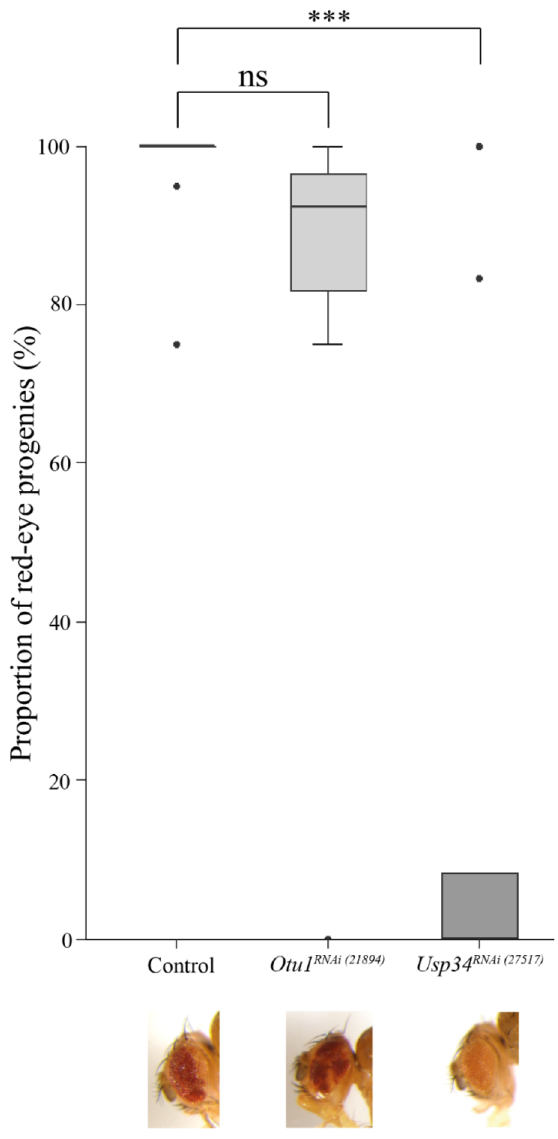
Figure 3. Phenotypic changes were obtained using I-SceI-induced site-specific DSB system in Otu1 RNAi (21894) and Usp34 RNAi (27517) DUB mutants (DR-white assay). The DR-white assay allows determining the choice of the repair pathway following I-Sce1-induced site-specific DSBs. Otu1 and Usp34 RNAi transgenes were driven by da-GAL4, the L3 larvae were heat-shocked to induce site-specific DSBs in the DR-white transgenes, and the mosaic red-eye phenotype was detected. Representation of the ratio of red-eye phenotype applying the euchromatic DR-white system. In case of Otu1 RNAi (21894) we used heat-shock-induced yw; DR-white.y + (DR-white_2eu_1)/hsp70.HA.I-Sce, Sco; da-GAL4/Otu1 RNAi (21894) adult flies and compared the number of flies with red eye to the total number of the flies with the above-described genotype. In case of Usp34 RNAi (27517) we used the same quantification by measuring the red-eye mosaic phenotype. The heat- shock-induced yw; DR-white.y + (DR-white_2eu_1)/hsp70.HA.I-Sce, Sco; da-GAL4/Usp34 RNAi (27517), flies were counted and the mosaic red-eye adult flies were compared to the total number of the adult flies with the above-described genotype. For the control, we used y w; DR-white.y + (DR-white_2eu_1)/hsp70.HA.I-Sce, Sco; da-GAL4/ + Drosophila lines with the same quantification method as was used for Usp34 RNAi (27517) and Otu1 RNAi (21894) . For the statistical analysis, Welch’s ANOVA in combination with Dunnett’s T3 post-hoc test was used. Significant values are indicated as follows: *P < 0.05, **P < 0.01, ****P < 0.0001. Data were obtained from nine independent experiments. More details about the DR-white system are described in a previous study 31